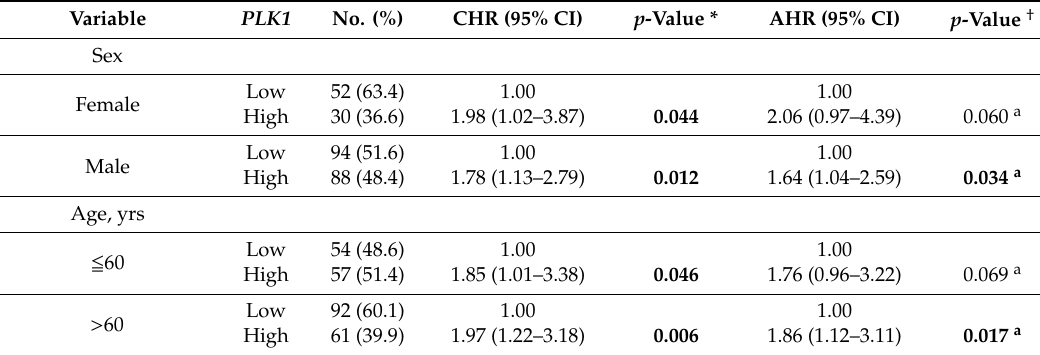
Table 2. Impact of PLK1 expression levels on overall survival by the di ff erent demographic and clinicopathologic factors with